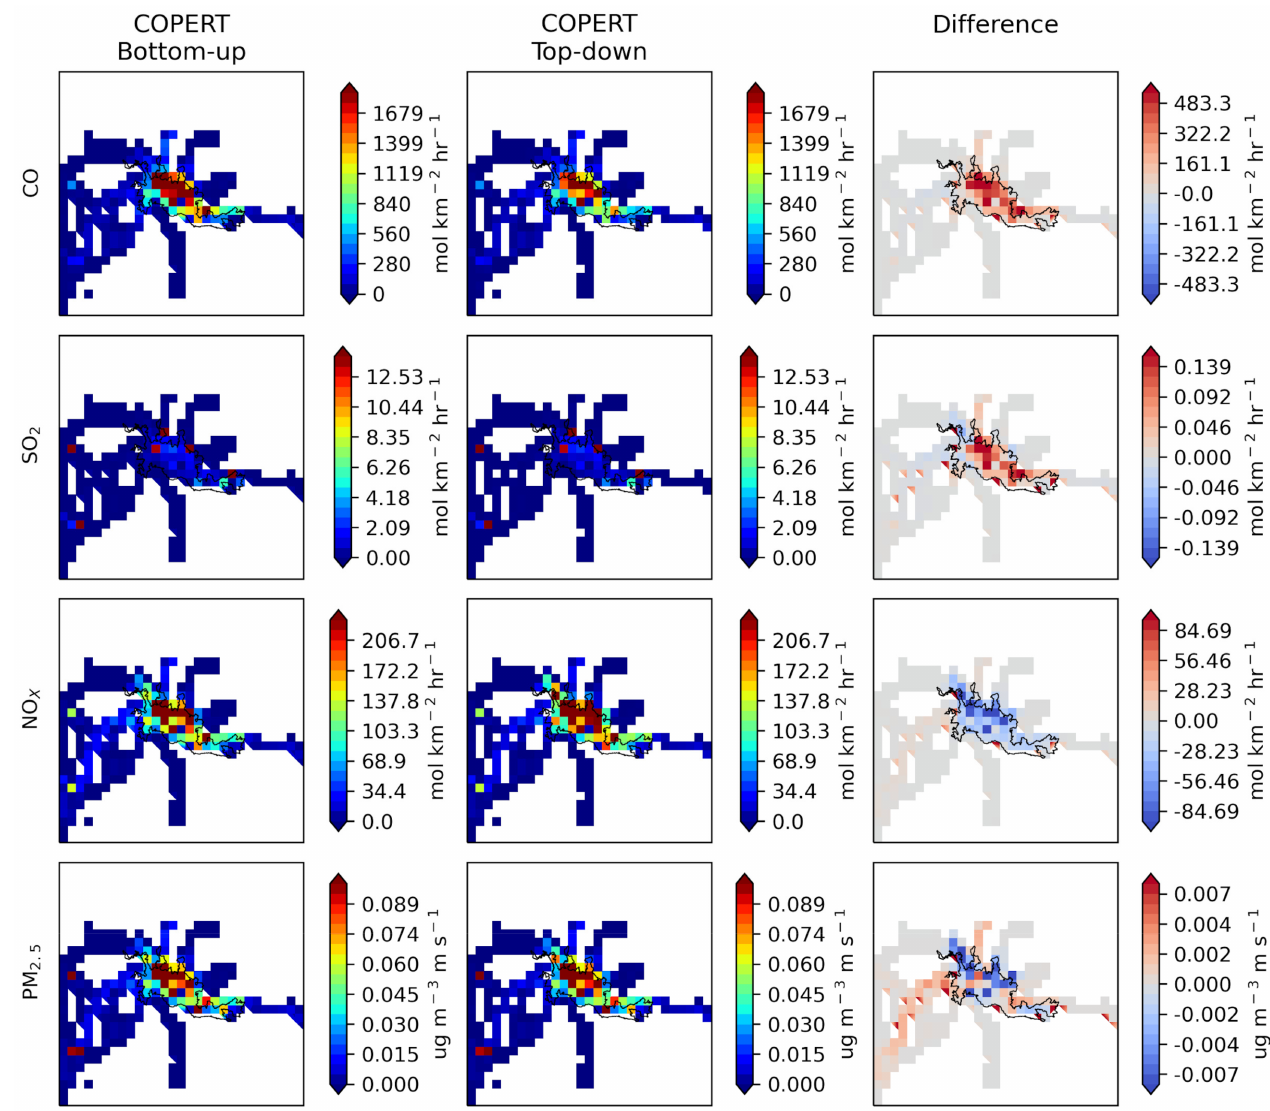
Figure 4. Spatial distribution of emissions of the COPERT/bottom-up and COPERT/top-down EIs, and difference map (bottom-up minus